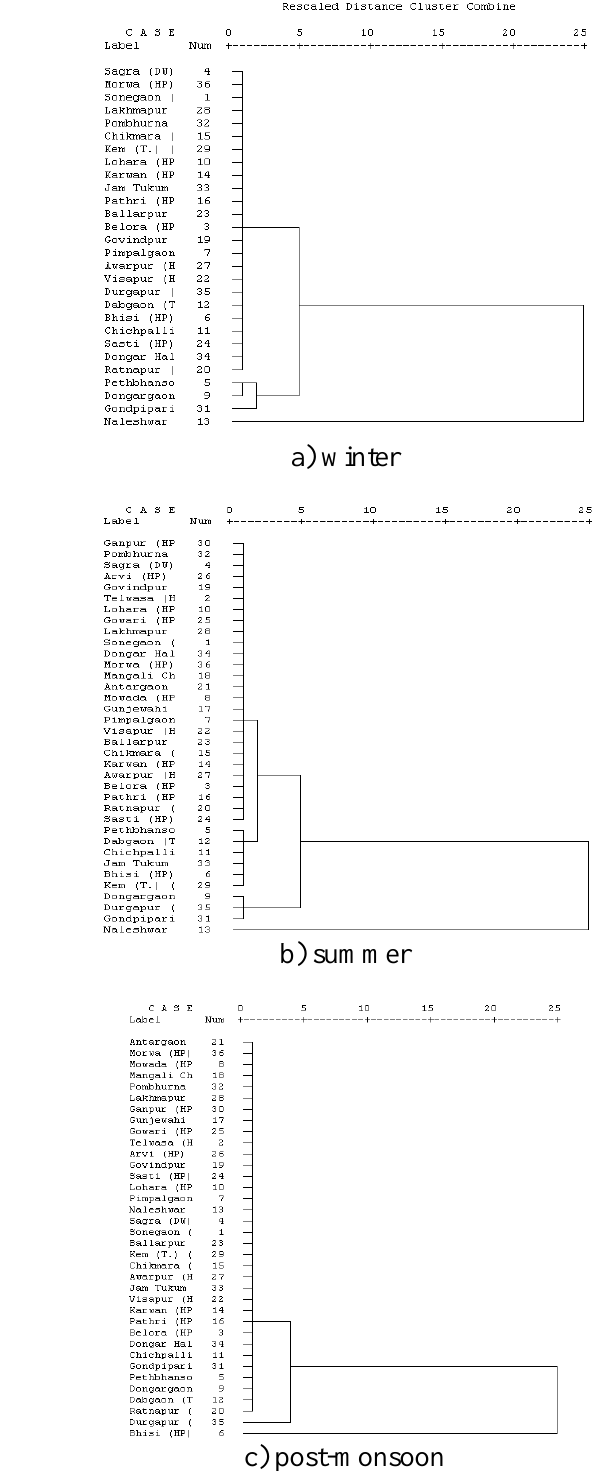
Figure 7. Cluster analysis of manganese Bhisi, Kem (Tukum) and 4) other 26 sampling locations. Clusters 3 and 4,due to the similarity in groundwater manganese concentrations, have close proximity to each other. Cluster 1 which includes Naleshwar